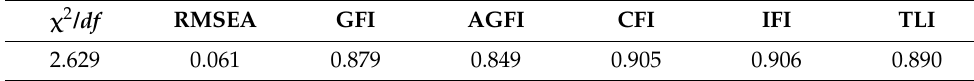
Table 13. Normalized Path Coefficients of Modified SEM.